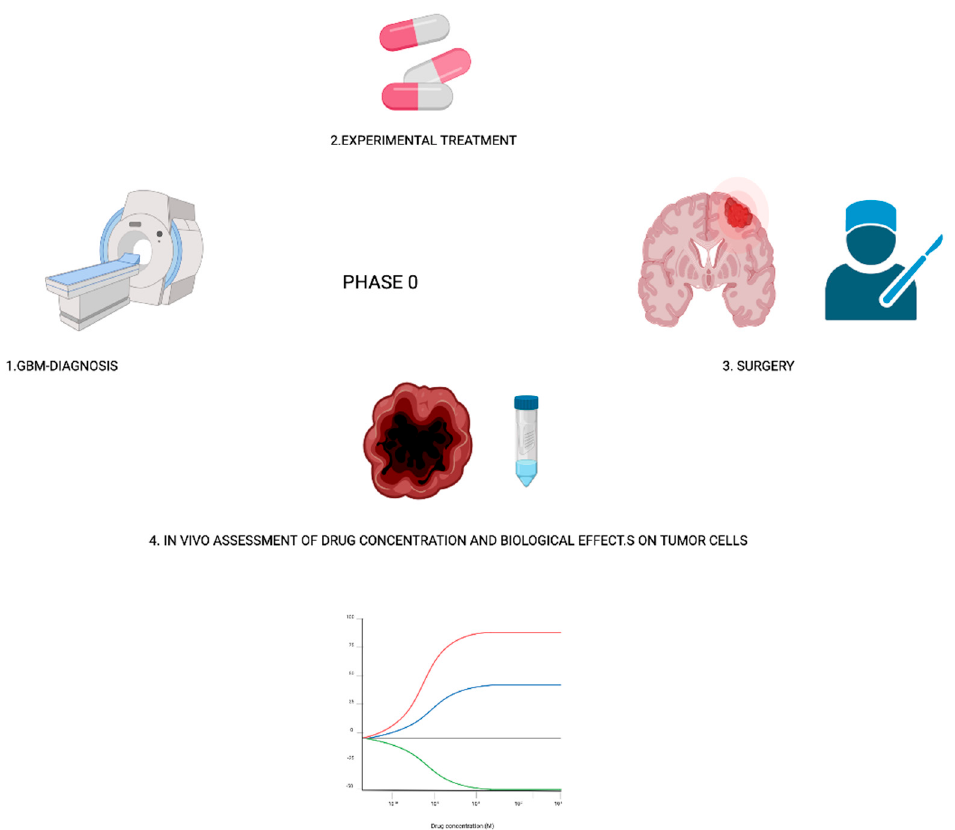
Figure 1. Phase 0 study overall design.